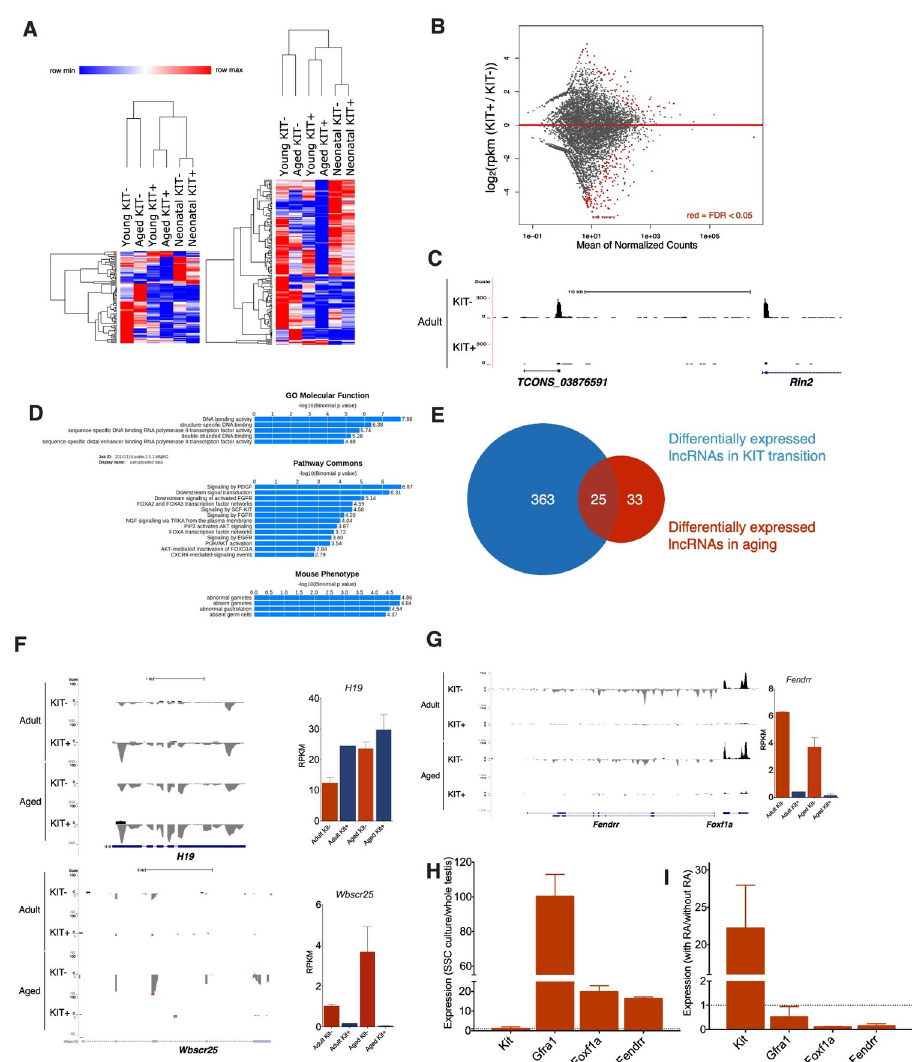
Fig 4. Expression of lncRNAs is tightly regulated during SSC differentiation and aging. (A) Heatmaps showing hierarchical clustering of differentially expressed transcripts of both known and novel lincRNA. (B) The MA plot shows the logarithm of the ratio between expression levels in KIT- and KIT+ populations versus the average expression of individual genes. The red dots depict the differentially expressed lncRNA (FDR < 0.05). (C) UCSC Genome Browser tracks for the KIT- cells specific novel lncRNA TCONS_03876591. (D) Functional prediction of lncRNAs regulated during differentiation by “Guilt-by-association” (GBA) analysis. (E) Venn diagram showing the number of lncRNAs with highly significant expression difference during KIT transition and aging (FDR < 0.05) and 25 lncRNAs found commonly involved in both processes. (F) UCSC Genome Browser tracks for H19 and Wbscr25 with expression levels shown on the right. (G) UCSC Genome Browser tracks for Fendrr with expression levels shown on the right. (H) Relative expression levels of Fendrr and Foxf1a between SSC culture and whole testis (dash dot line: y = 1). (I) Expression level changes of Fendrr and Foxf1a after RA treatment (dash dot line: y = 1).